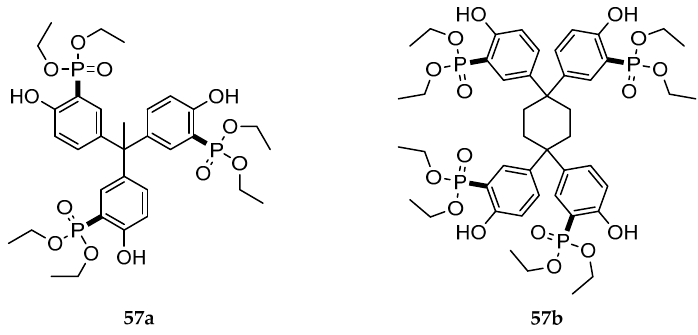
Figure 28. Phosphonate derivatives of polyphenols 57a and 57b .